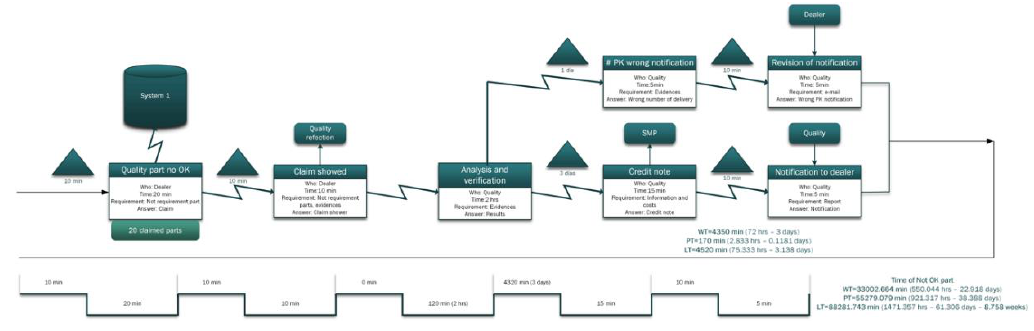
Figure 9. The seventh part of seven of the Current VSM is displayed.